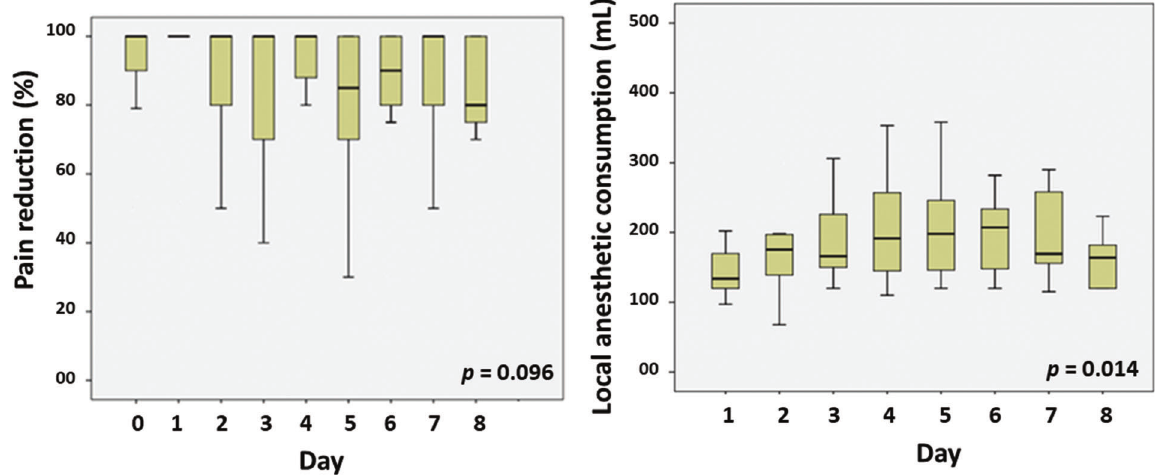
Figure 3 - Pain reduction after the onset of CPNB and local anesthetic consumption throughout CPNB days. Day 0: immediate post CPNB initiation. Friedman